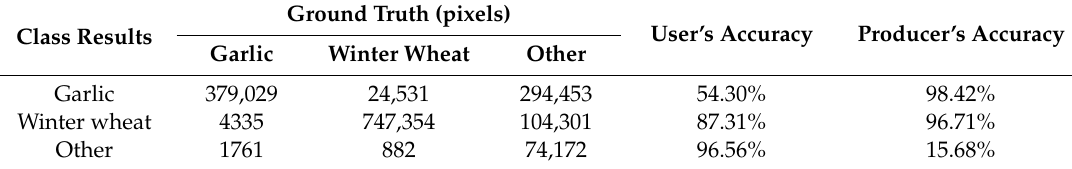
Table 2. Results of accuracy validation for garlic and winter wheat classification results (GWC).